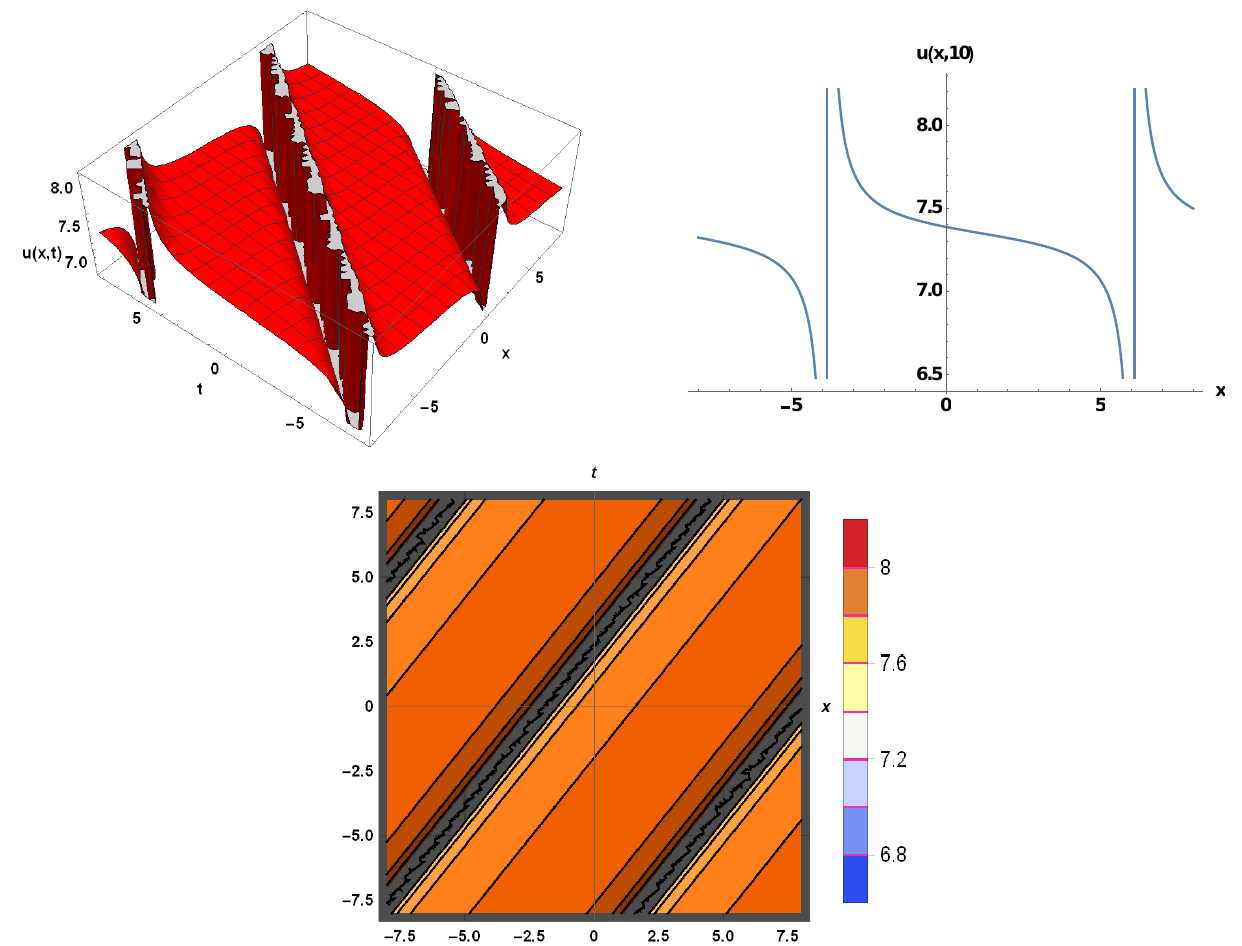
Figure 4. The solitary wave view of 3D, 2D, and contour plots of U 4 ( x , t ).